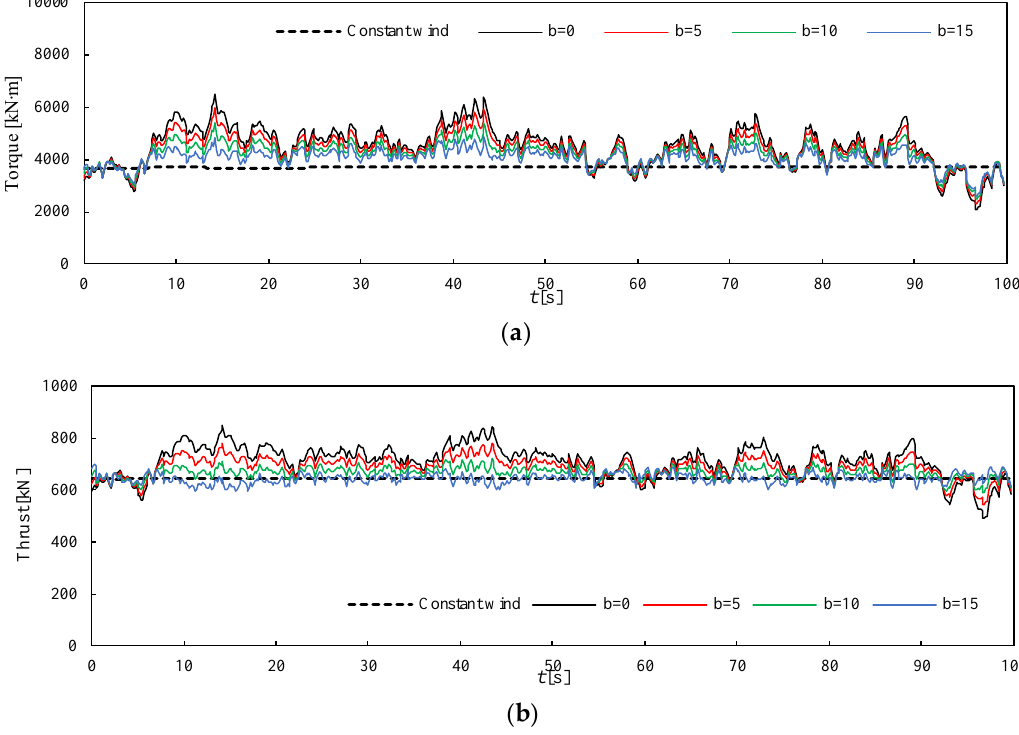
Figure 17. Torque and thrust response of the wind turbine rotor under turbulent wind conditions for U mean = 11.4 m/s. ( a ) Torque response; ( b ) thrust response.